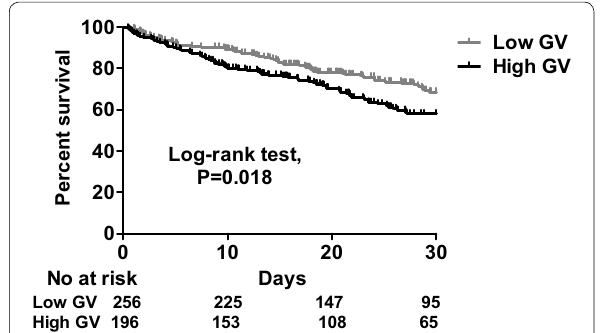
Fig. 2 Kaplan–Meier survival curves categorized by glycemic variability. Low GV, MAGE 65; high GV, MAGE > 65 ≤